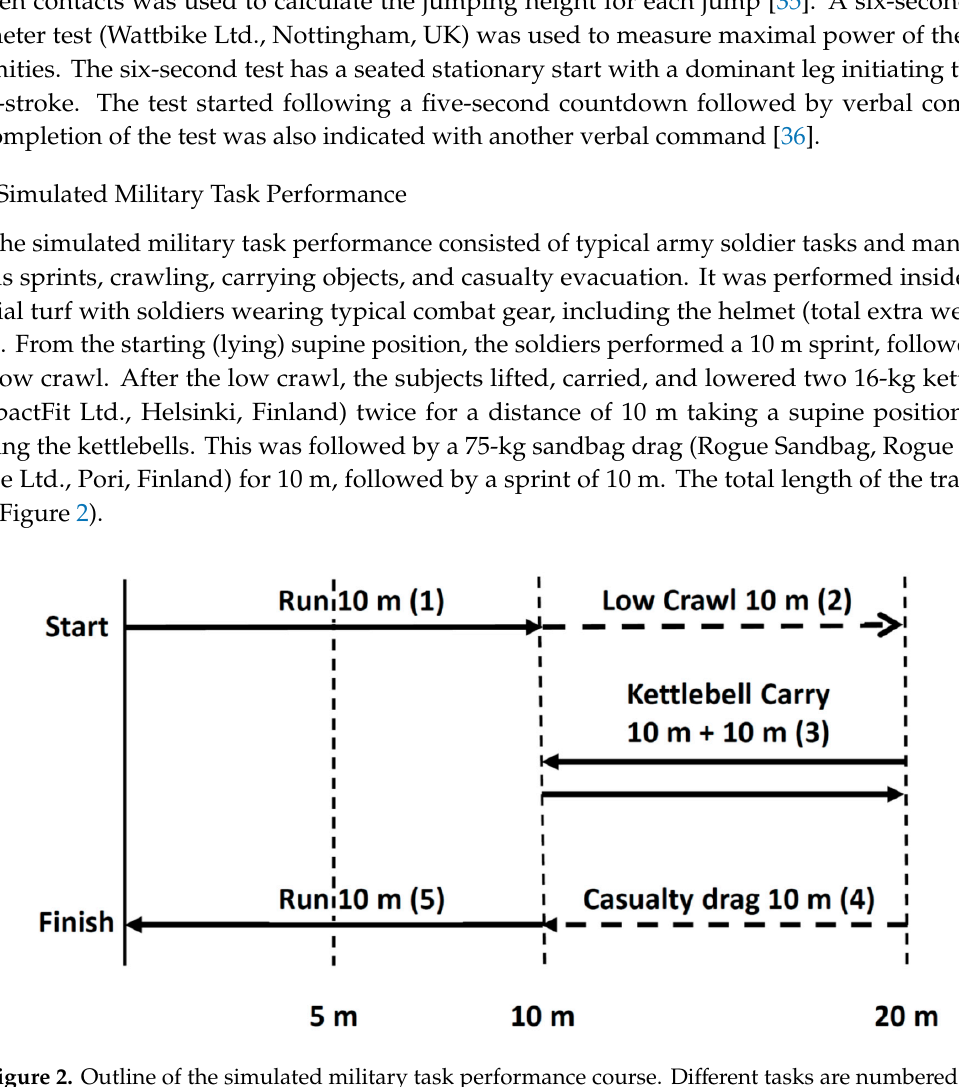
Figure 2. Outline of the simulated military task performance course. Di ff erent tasks are numbered in the order of performance